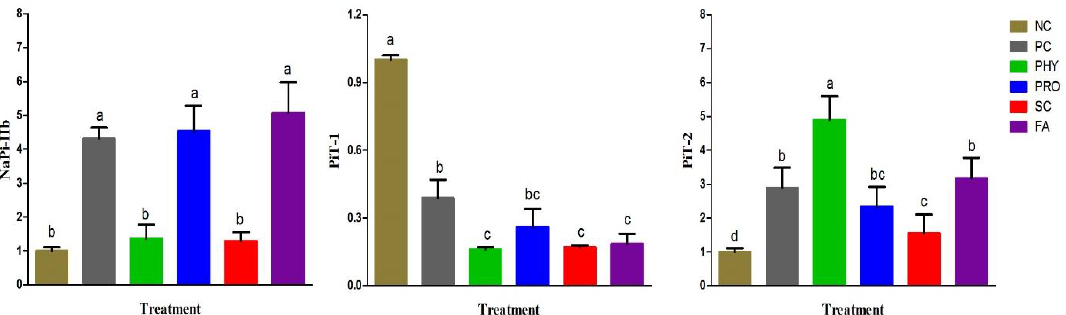
Figure 4. Effect of dietary treatments on phosphorus transporter gene expression of broiler chickens at 35 d of age. Expression of NC is taken as 1.0. Data represented as mean ± SE. a – c Means with different letters varied at p < 0.05. For treatment abbreviations, see Table 2. NaPi-IIb, type IIb sodium- dependent phosphate co-transporter; PiT-1, inorganic phosphate transporter 1; PiT-2, inorganic phosphate transporter